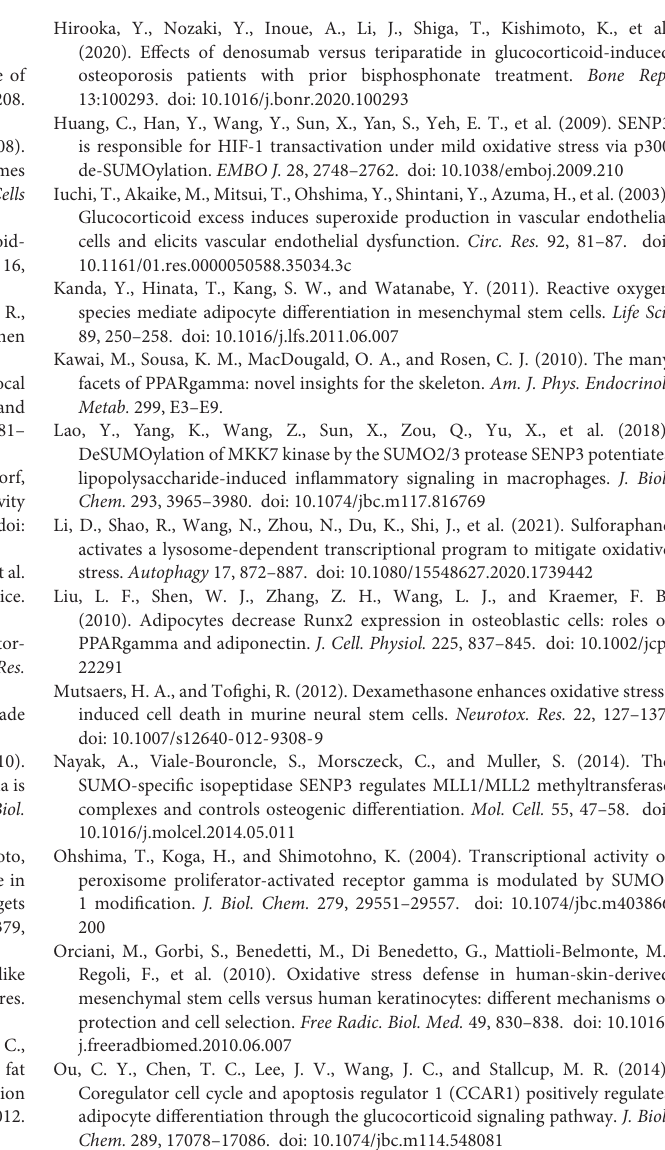
Supplementary Figure 1 | The protein levels of SENP3 in BM-MSCs was upregulated while the mRNA levels of SENP3 remained nearly unchanged during adipogenesis and osteogenesis. The protein levels of SENP3 in BM-MSCs of control group and after 7-day adipogenic (A) and osteogenic (C) induction were shown by Western Blotting and the ratio of SENP3/ β -actin was listed below; the mRNA levels of SENP3 in BM-MSCs of control group and after 7-day adipogenic (B) and osteogenic (D) were analyzed by Q-PCR. Data are shown as the mean ± SEM, ns: not significant. All the data were obtained from at least three independent